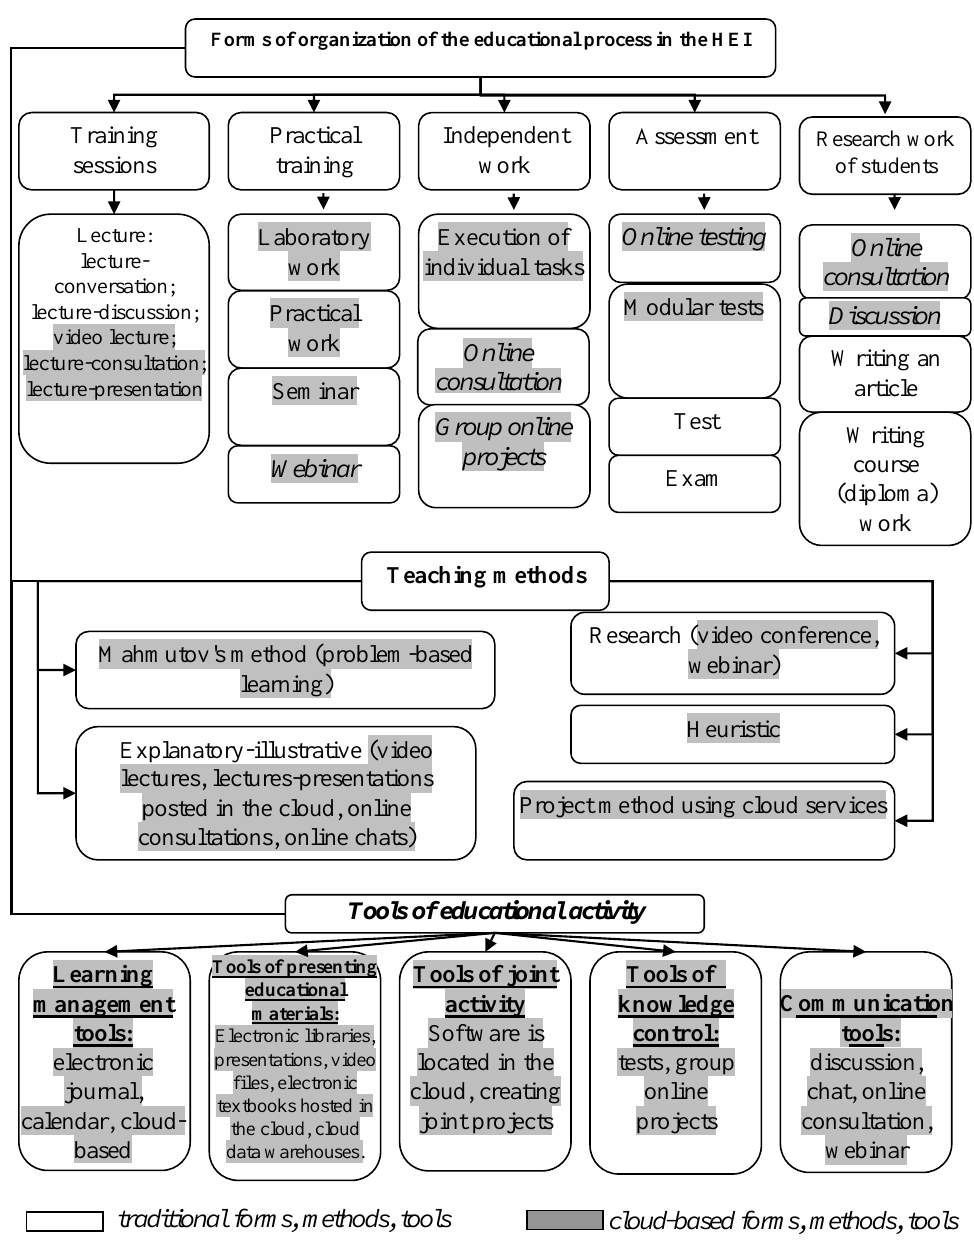
Figure 3: Forms of organization of the educational process, methods and learning tools in